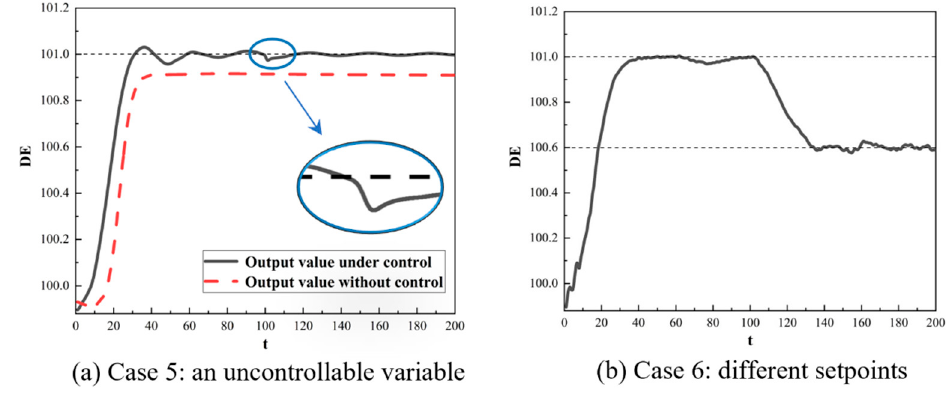
Figure 12. The state pro fi les for uncontrollable variables and di ff erent setpoints.